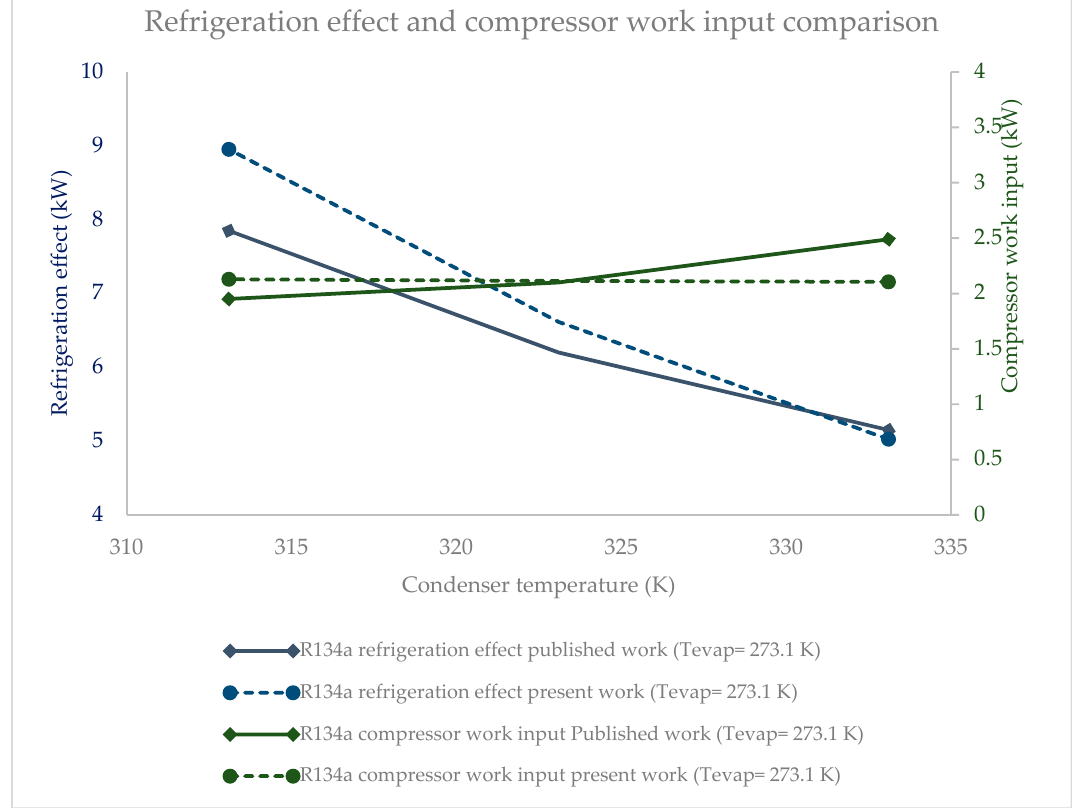
Figure 2. Comparison of the EES model for refrigeration effect and compressor work.